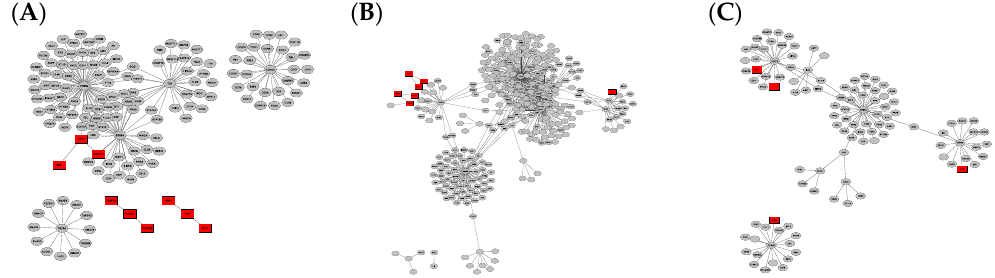
Figure 2. Graph clusters from StringDB showing unique difference networks between the intersection of all three disease-type constructed networks and each type-specific network with ( A ) general glioma, ( B ) glioblastoma multiforme and ( C ) low-grade astrocytoma. Graphs were rendered with Prefuse Force Directed Layout, clustered by ClusterOne (grey: outlier, yellow: overlap, red: cluster).